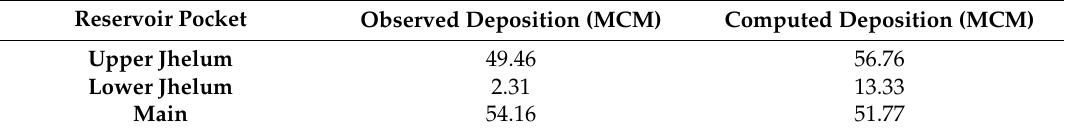
Table 3. Sediment deposition in di ff erent pocket of reservoir from 2005 to